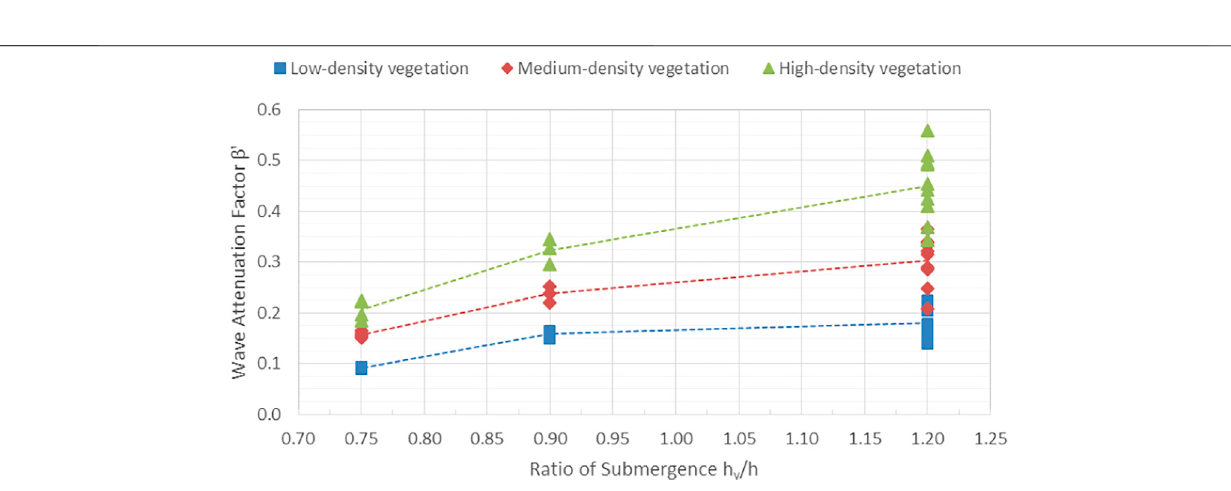
Frontiers in Built Environment |